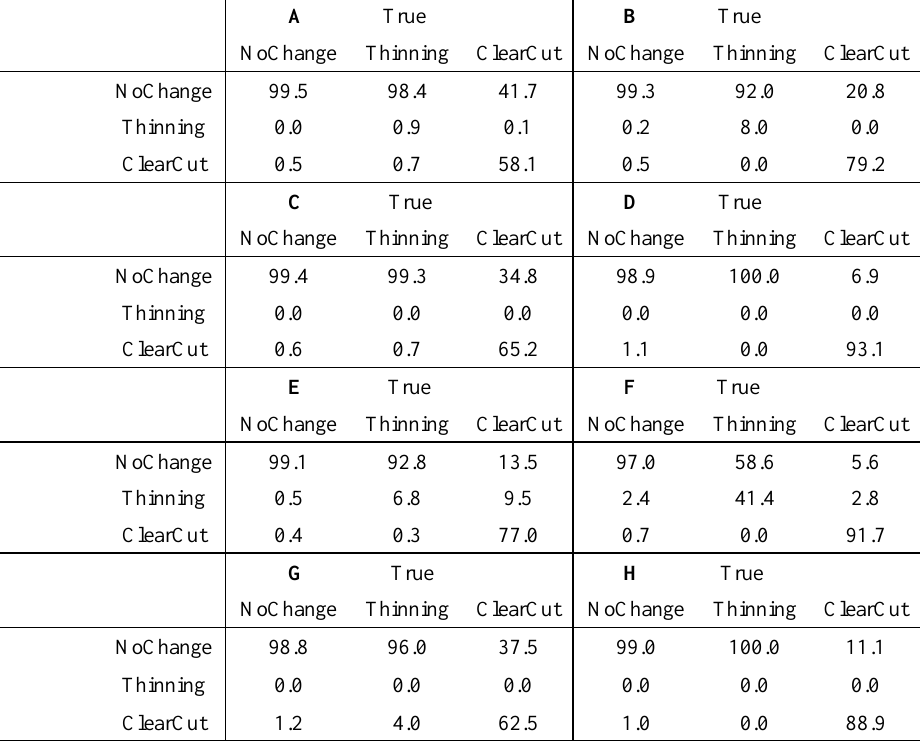
Table 4. Confusion matrix for predictions for the categories ClearCut, thinning, and NoChange. Values are percentages. (A) Pixel- level predictions made with model 1. (B) Stand-level predictions made with model 1. (C) Pixel-level predictions made with model 2. (D) Stand-level predictions made with model 2. (E) Pixel-level predictions made with model 3. (F) Stand-level predictions made with model 3. (G) Pixel-level predictions made with model 4. (H) Stand-level predictions made with model 4.